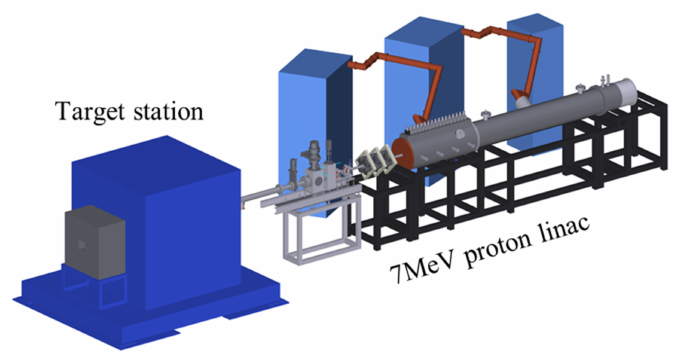
Figure 1. Schematic drawing of